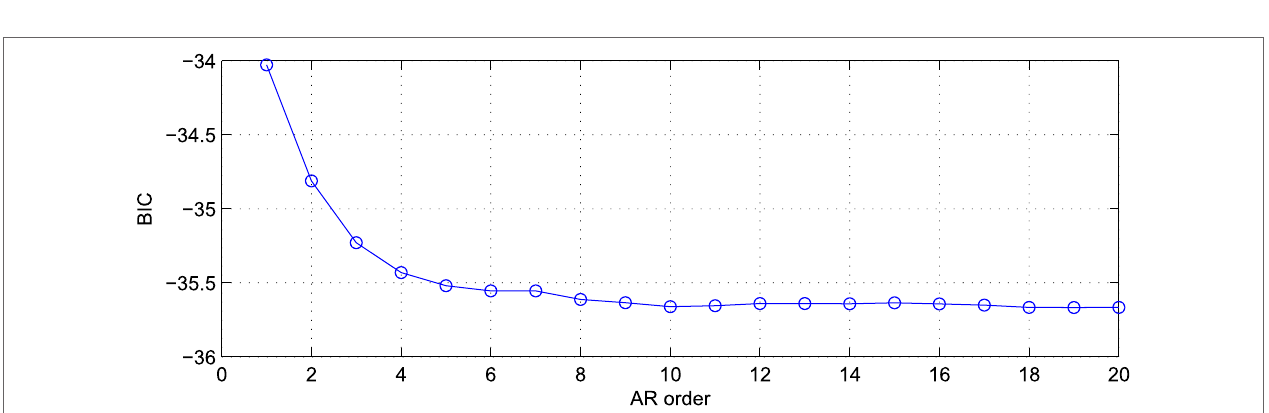
FIGURE 9 | Evolution of the Bayesian information criterion (BIC) for increasing model order .